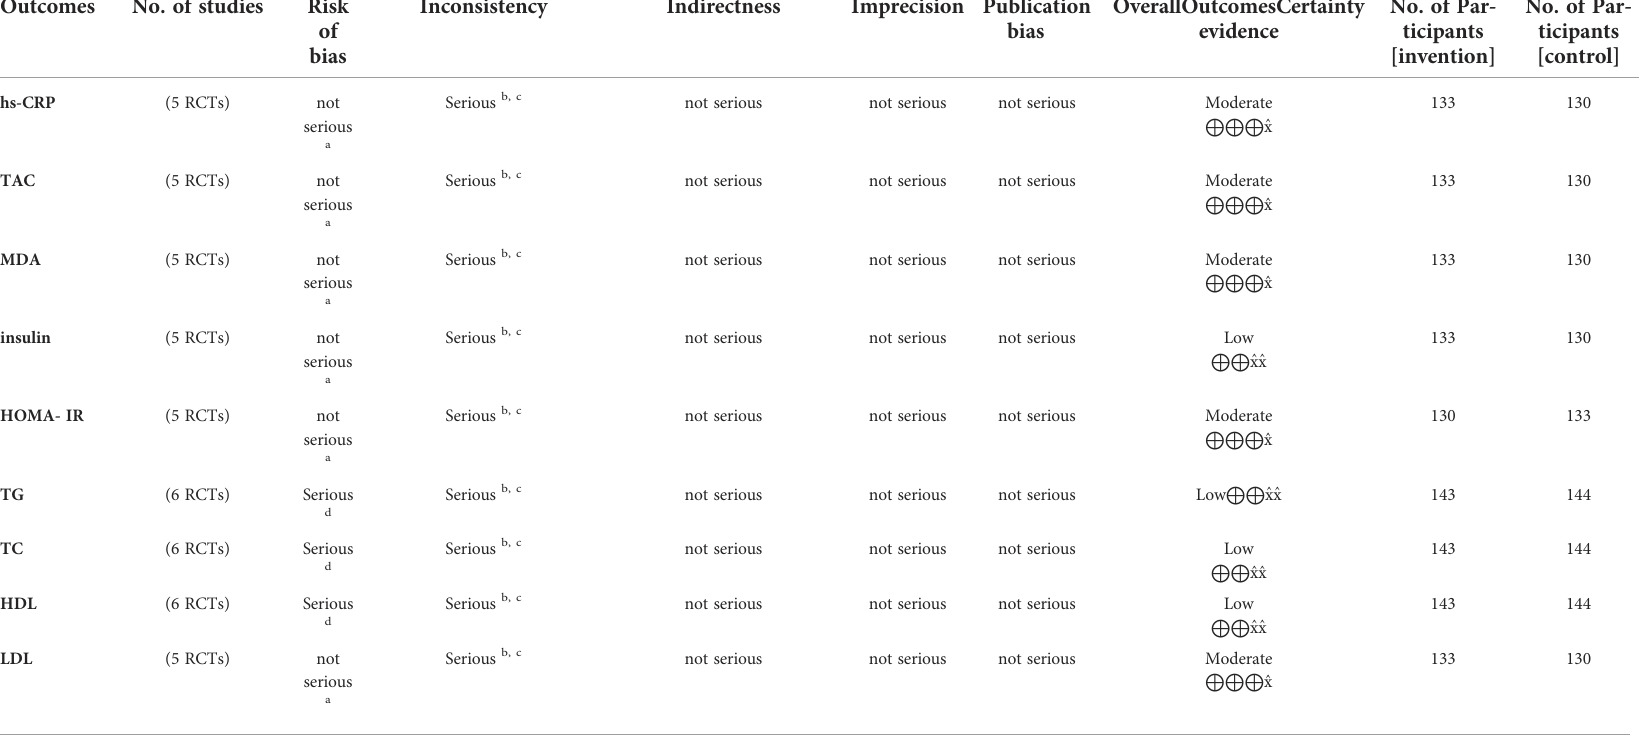
TABLE 4 Quality of evidence in the included systematic reviews with GRADE.